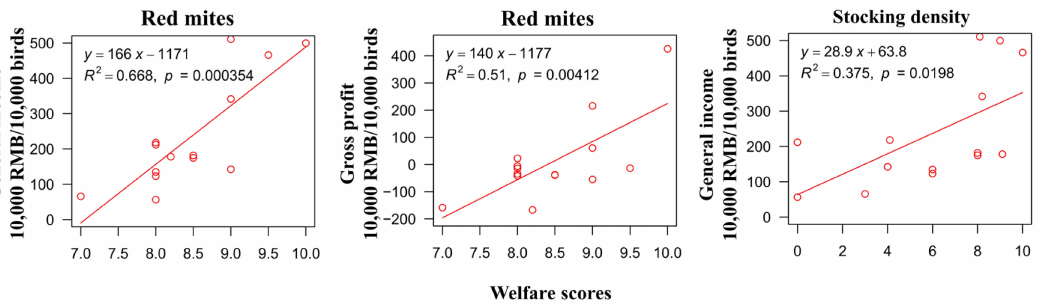
Figure 10. Linear regression relationship between economic indices for free-range farms and score for welfare